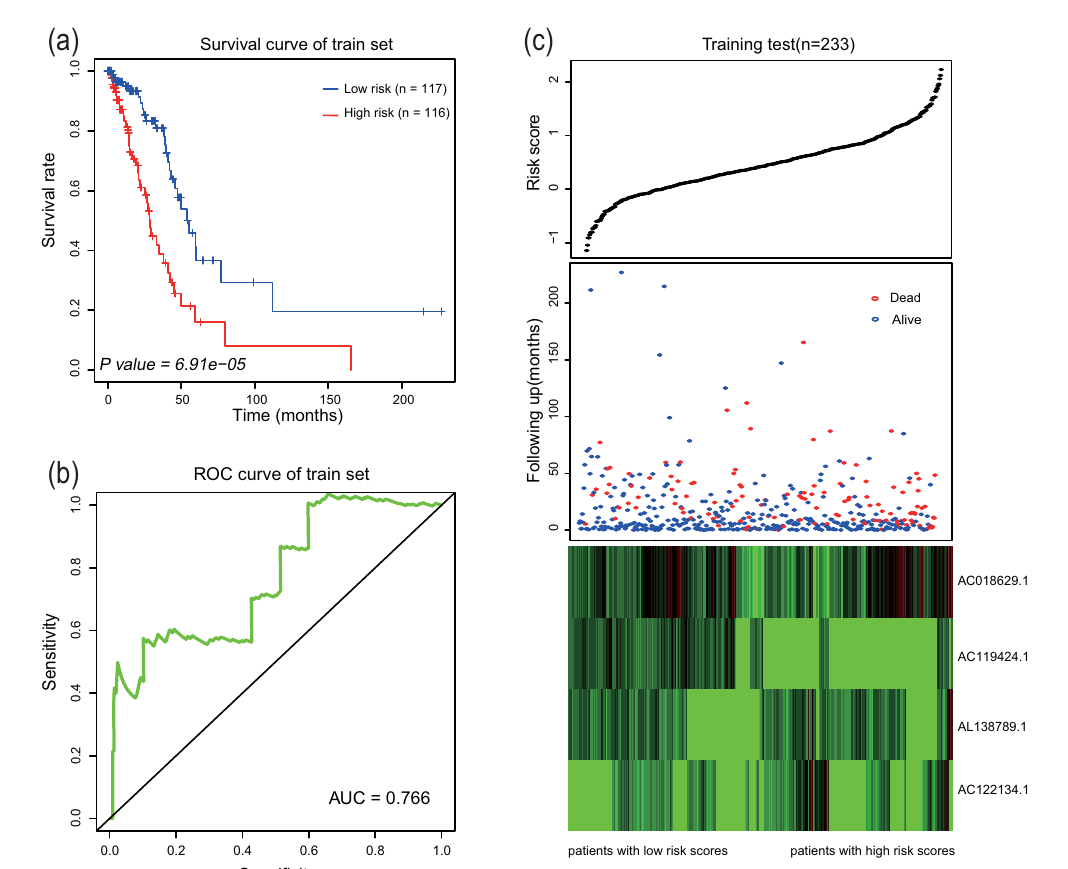
Figure 2: The four - lncRNA associated risk score model predicted the OS of LUAD patients in the training set. ( a ) Kaplan – Meier assessment of the survival of patients with LUAD in the high - risk and low - risk groups. P value represents the di ff erence between the two curves according to the results of two - sided rank test. ( b ) The ROC curves were used to calculate the AUC and the sensitivity and speci fi city to evaluate the performance of the score. ( c ) Distribution of the four - lncRNA based risk score distribution, survival status of the patients, and heatmap expression pro fi les of four